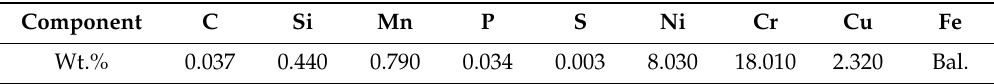
Table 1. Chemical composition of